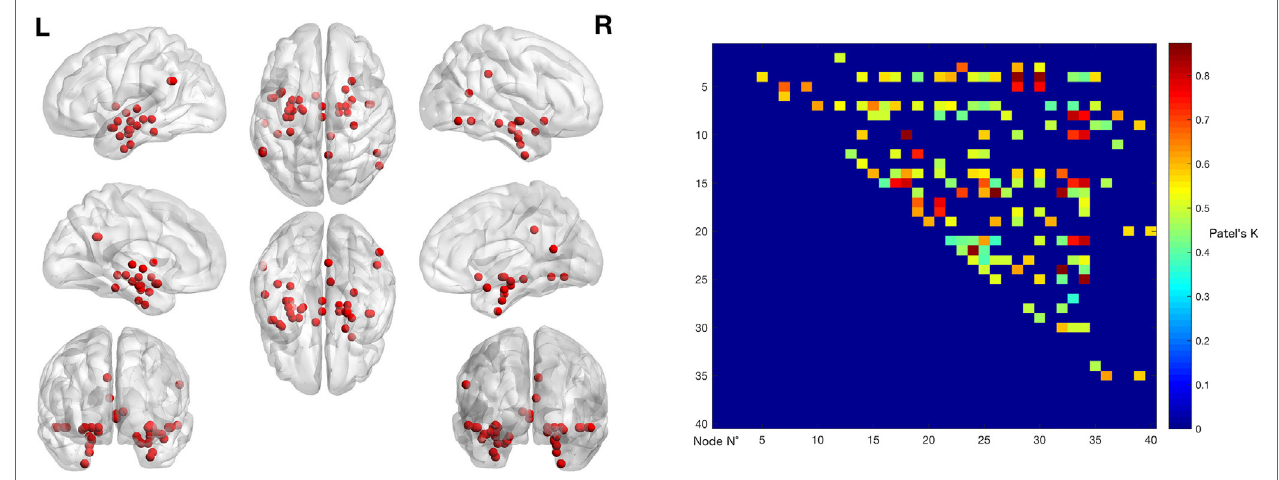
FigUre 2 | The left panels shows the nodes that entered the coatrophy calculation. The right panel shows the coatrophy matrix. Colors from blue to red indicate increasing Patel’s k values (i.e., increasing coalteration probabilities).